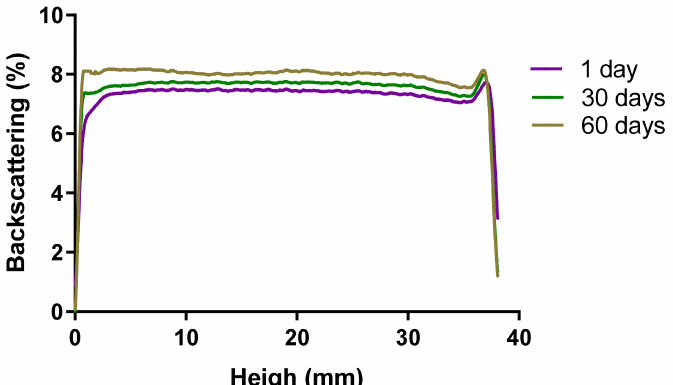
Figure 6. PF-NLCs-F127 hydrogel backscattering profiles obtained by the Turbiscan ® Lab (Formulac- tion Co., L’Union, France) stored at 25 ◦ C. The left side of the curve corresponds to the bottom of the vial, whereas the right side corresponds to the sample behaviour at the